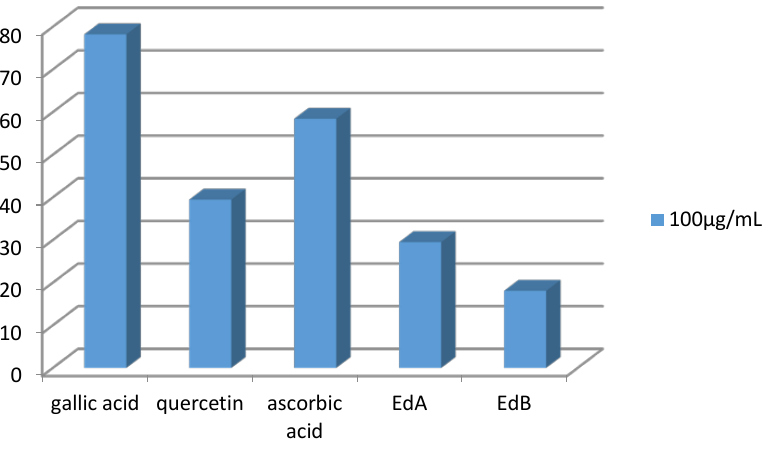
Figure 3. Comparison of DPPH inhibition between standards and both extracts at the same concentrations.